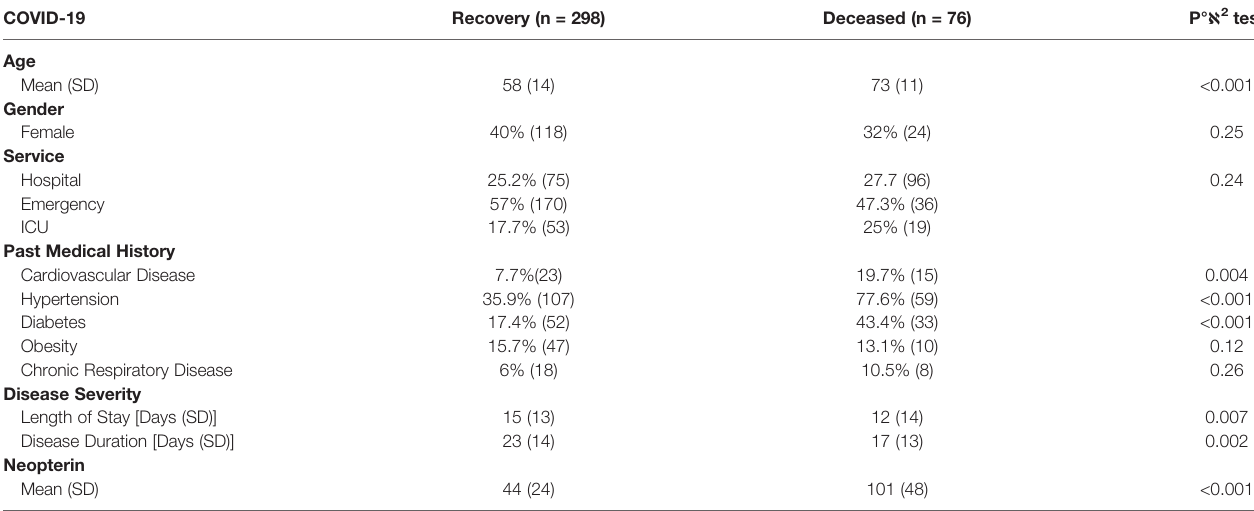
TABLE 1 | Patients ’